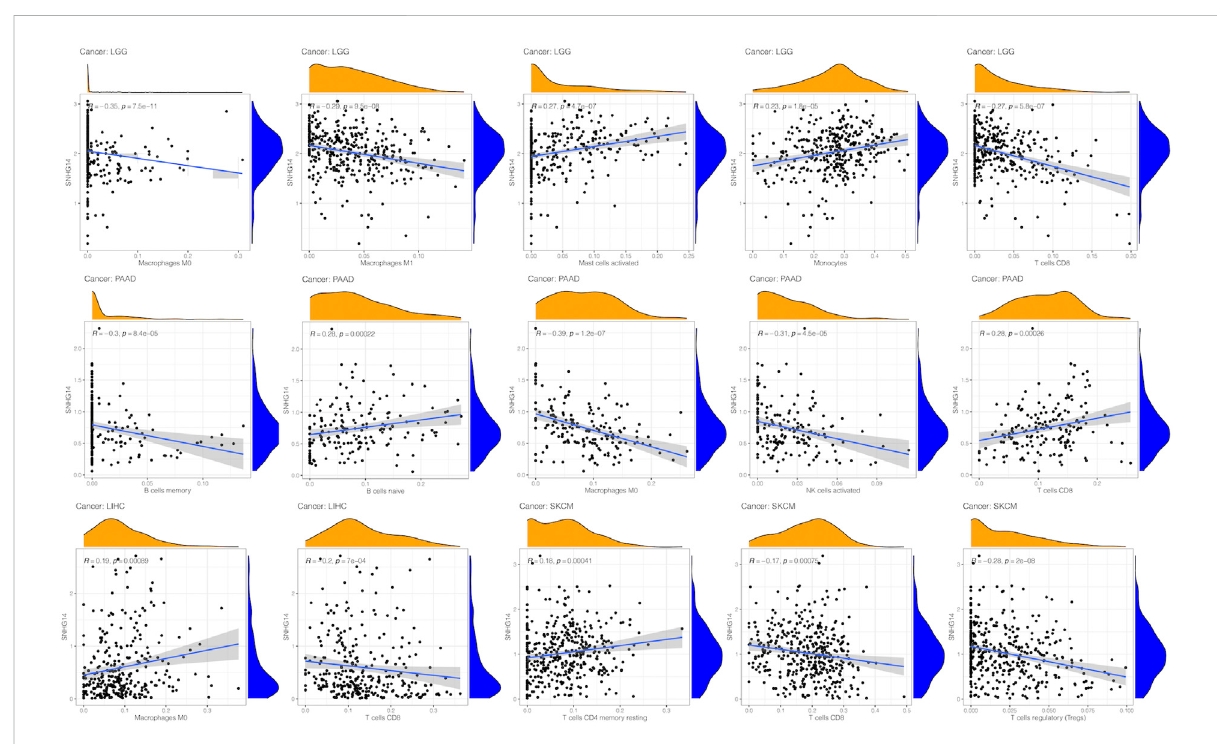
FIGURE 11 Relationship between SNHG14 gene expression and in fi ltrating levels of immune cells in LGG, PAAD, MESO, SKCM, LIHC.